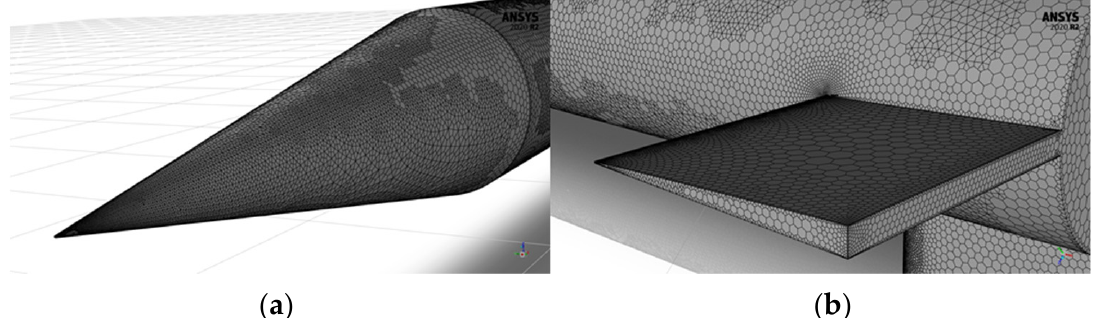
Figure 4. Unstructured Meshing details: ( a ) Nose section; ( b ) Fin section .